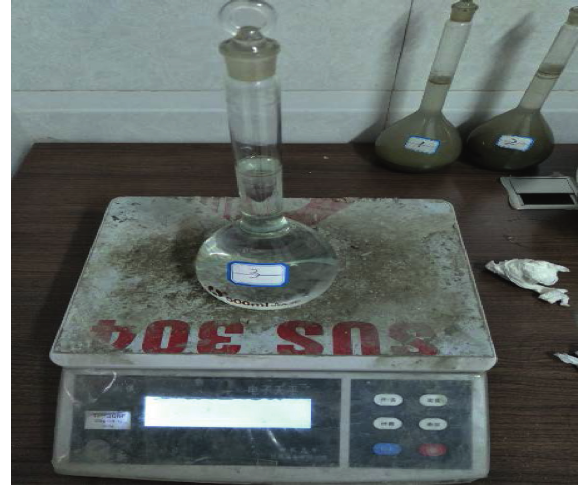
Figure 1: Gravity bottle weighing. Table 1: Gravity of total tailings.